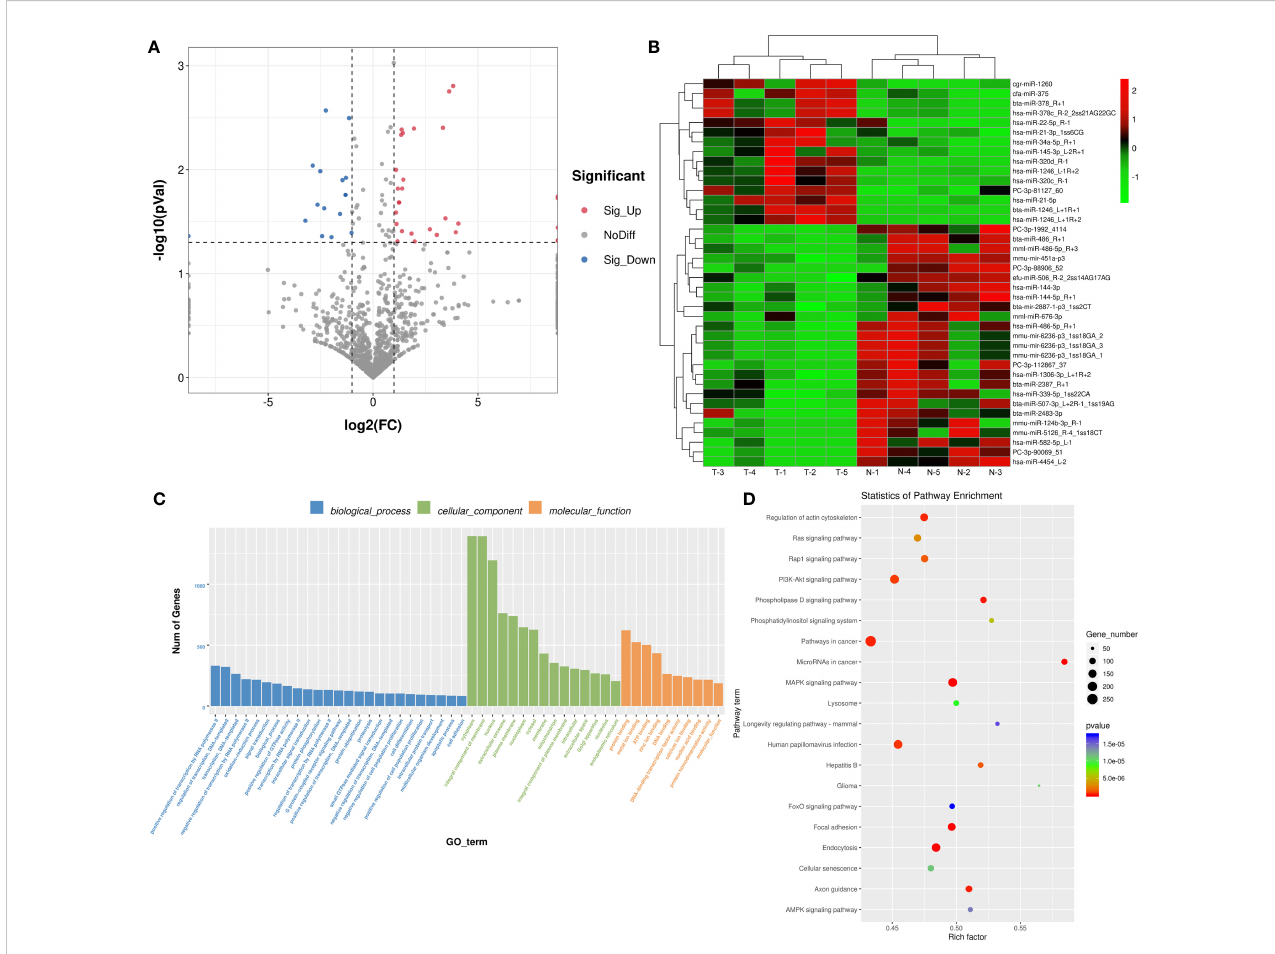
FIGURE 4 Identi fi cation of differential expressed microRNAs (DE-miRNAs) between the plasma-derived exosomes from thin and normal Bactrian camels. (A) The volcano fi gure of DE-miRNAs. (B) The bidirectional hierarchical cluster analysis of these DE-miRNAs. (C) Gene Ontology (GO) terms of these DE-miRNAs in biological process, cellular component, and molecular function. (D) Kyoto Encyclopedia of Genes and Genomes (KEGG) pathways enrichment of these